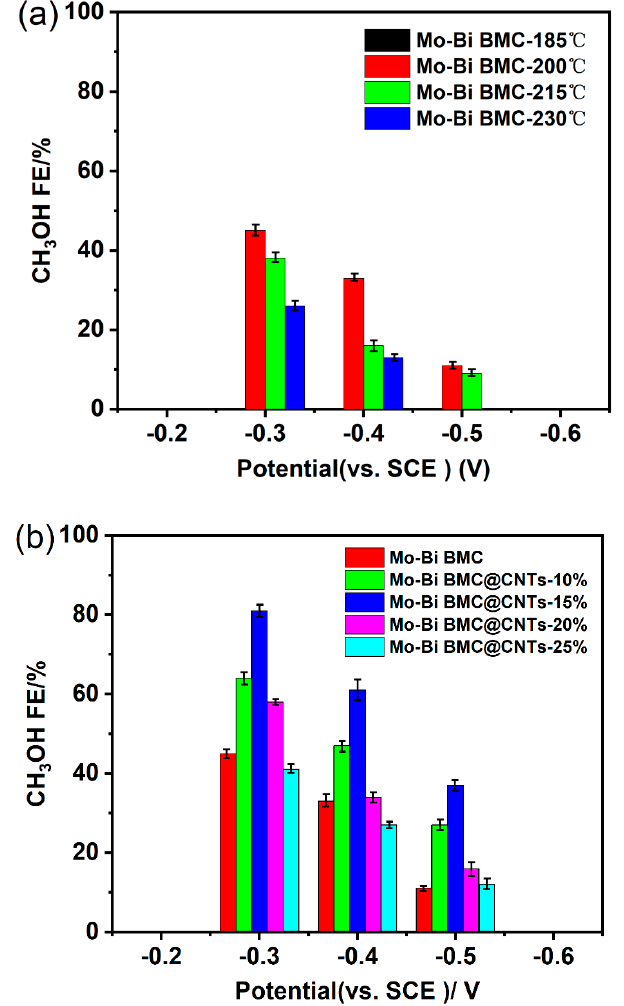
Figure 7. Faradaic efficiencies of methanol in the CO 2 RR over the Mo–Bi BMC ( a ) and Mo–Bi BMC@CNTs ( b ) as a function of the potentials.